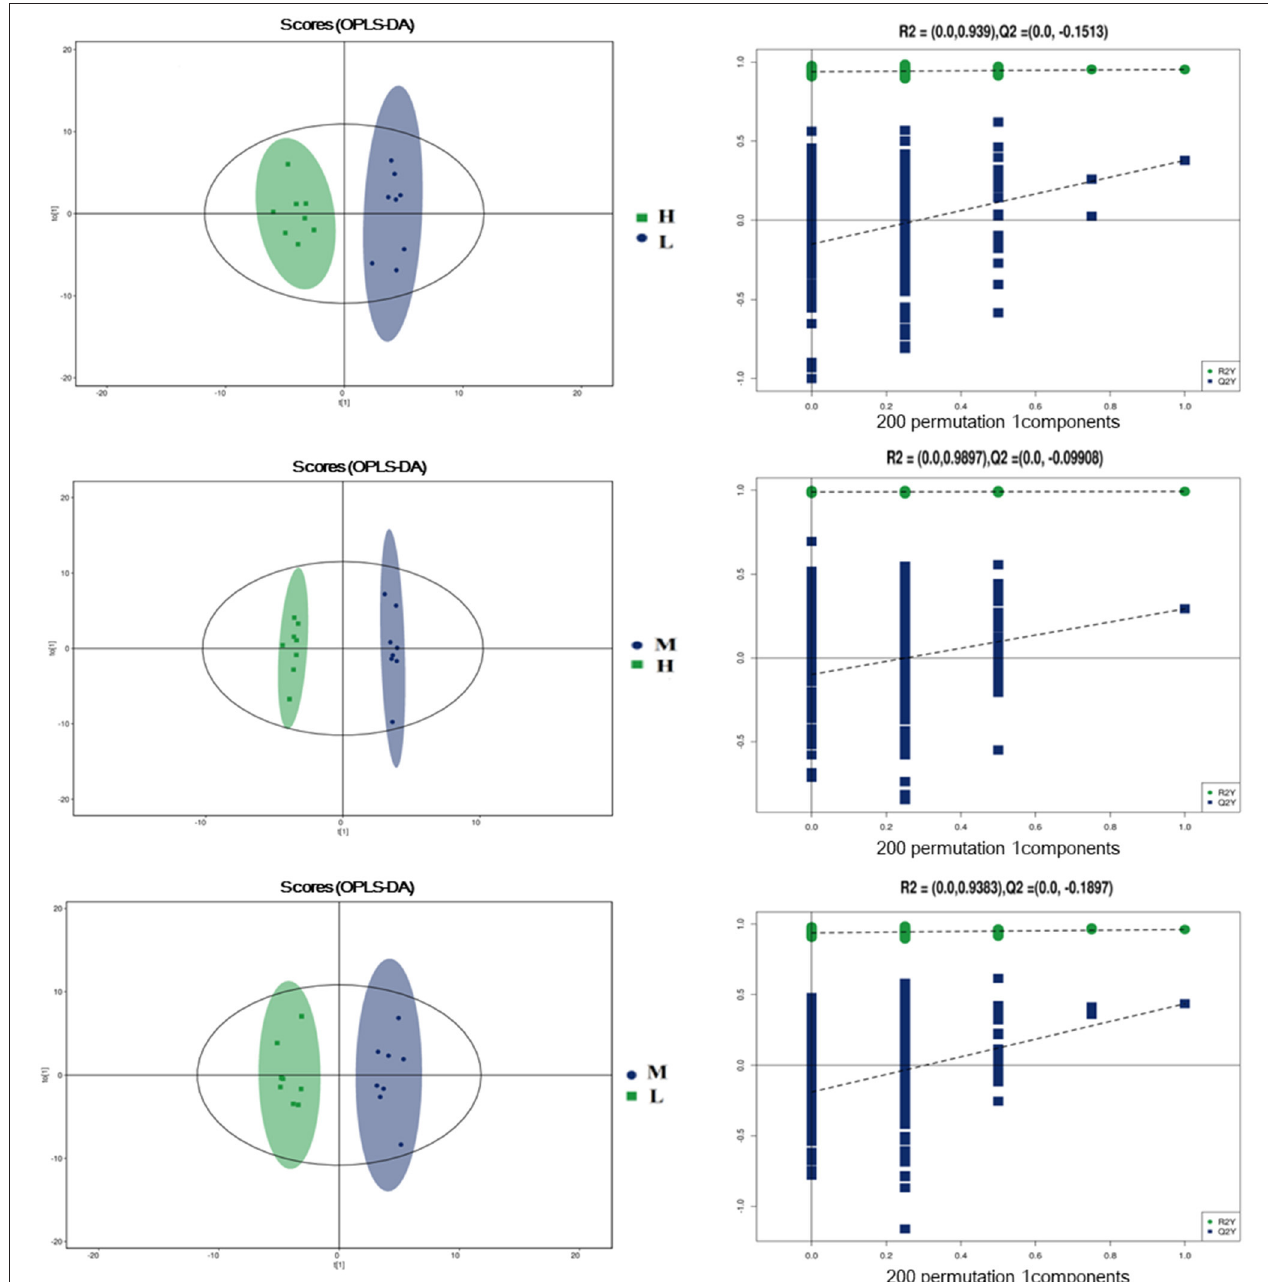
FIGURE 4 | Orthogonal partial least squares discriminant analysis (OPLS-DA) score plots in positive electrospray ionization mode (ESI + ) metabolomics profiles of plasma. L = 1,050 mg/kg choline group; M = 1,850 mg/kg choline group; H = 2,650 mg/kg choline group.